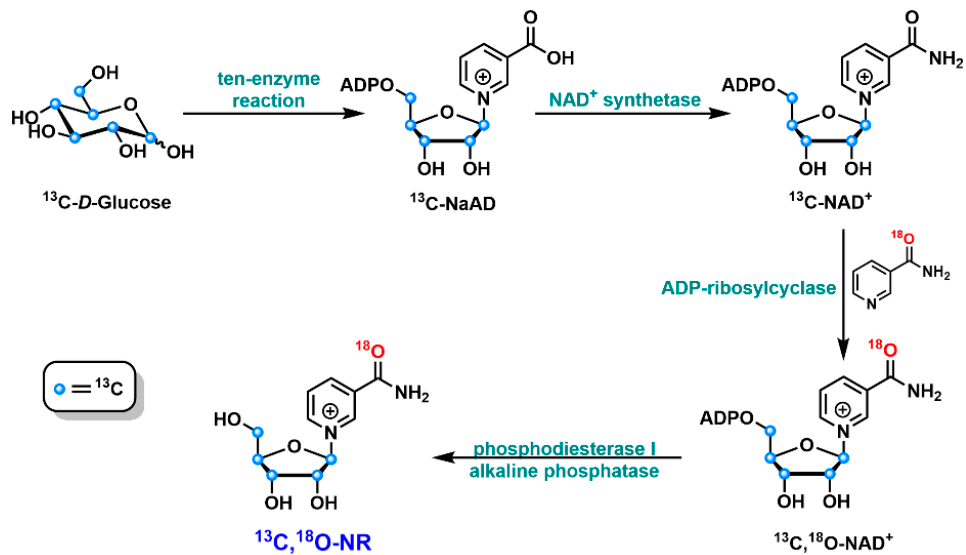
Figure 4. Schematic representation of the chemo-enzymatic synthesis of 13 C, 18 O-NR.